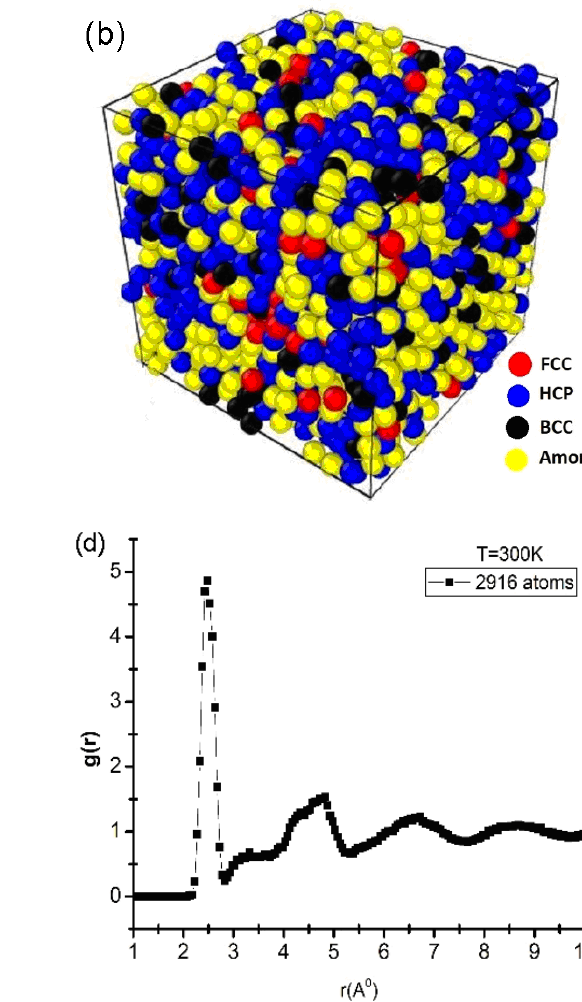
Figure 1. Initial shape ( a ), structure shape ( b ), number of structural units ( c ), and RDF ( d ) of bulk Cu 2916 material at temperature T = 300 K.